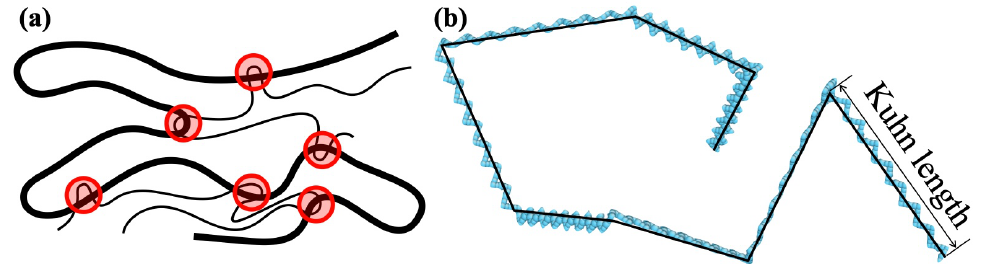
Figure 2. ( a ) Schematic illustration of entanglement points (red-shaded circles) along a polymer chain. ( b ) Kuhn segment length of coarse-grained (CG) molecular chain. The beads in light blue represent the CG particle, and short straight segments with 4 CG particles represent the monomer of PC. The Kuhn segment (solid black line) is composed of PC monomers aligned in a